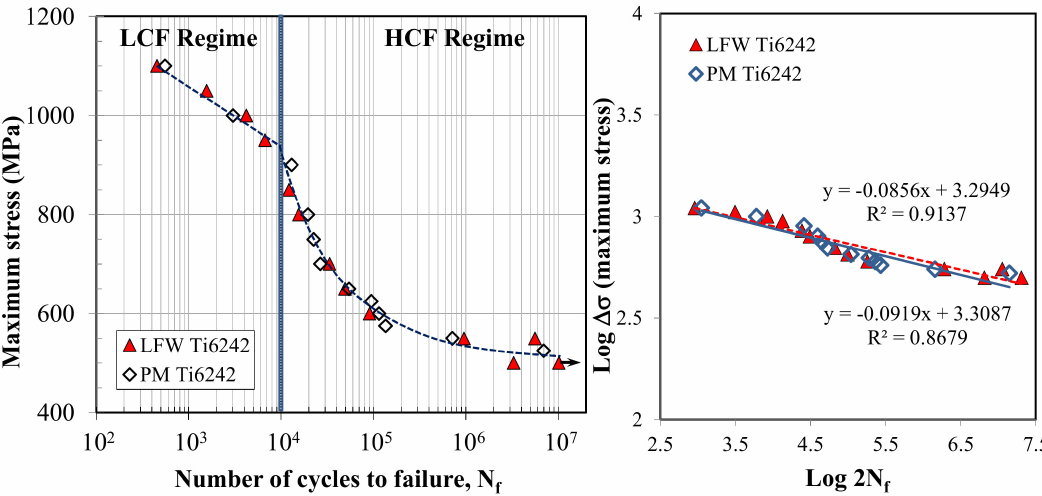
Figure 12. Fatigue life curve for Ti-6242 PM and SRAed linear friction welds tested at room temperature, R = 0.1: ( a ) semi-log scale plot of the maximum stress versus the number of cycles to failure (N f ) with the LCF and HCF regimes and ( b ) double log scale plot of the maximum stress versus the number of reversals to failure (2N f